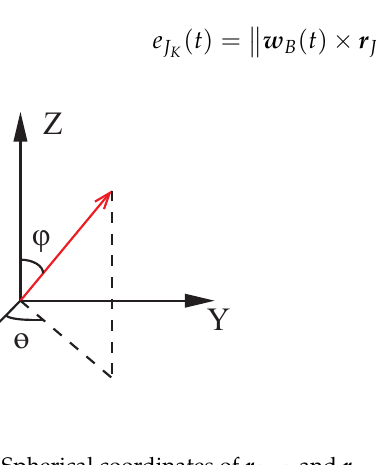
and r J K , B K , C